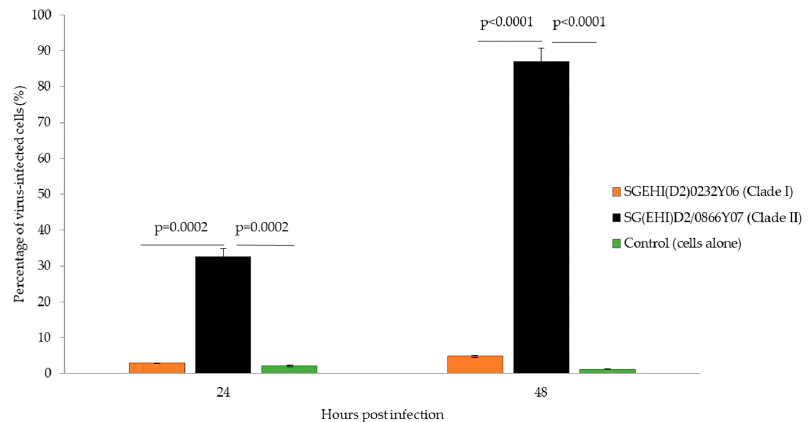
Figure 2. Percentage of K562 cells infected by DENV-2 strains. Cells infected with clade I and II isolates (M.O.I = 5) were collected between 24 and 48 hpi and subjected to flow cytometry with MAbs against the envelope protein. The data show means of triplicates and are representative of two independent experiments. Statistically significant observations are shown with p -values. Error bars indicate ± S.E.M.